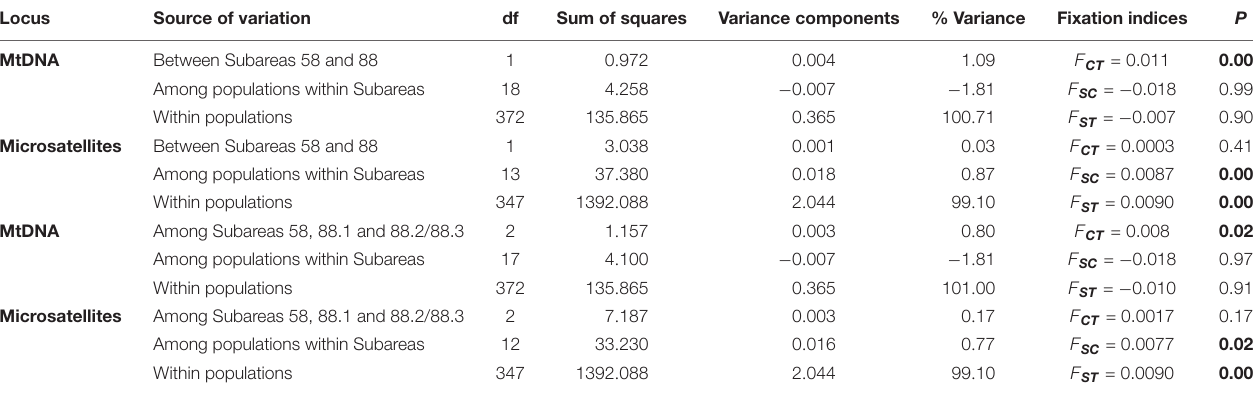
FIGURE 3 | Comparisons of the level of mtDNA COI and 16S (A) , seven microsatellite (B) diversity between the Subareas 58 (mtDNA: 10 populations, microsatellites: 5) and 88 (mtDNA: 10, microsatellites: 10). Levels of mtDNA diversity (HR, h , and π ) were significantly higher for the Subareas 58 than for the Subareas 88. Levels of microsatellite diversity (AR, H E , and H o ) tended to be higher for the Subareas 58, albeit statistical non-significance. **: P < 0.01, ***: P < 0.001. TABLE 2 | Hierarchical AMOVA (Analysis of Molecular Variance) for the 20 (mtDNA) and 15 (microsatellites) populations of Dissostichus mawsoni based on mtDNA (COI and 16S) and seven microsatellite loci according to two different groupings (Subareas 58 vs. 88, Subareas 58 vs. 88.1 vs. 88.2/88.3). Locus Source of variation df Sum of squares Variance components % Variance Fixation indices